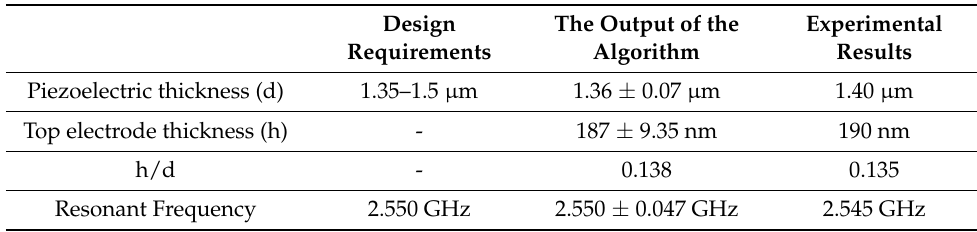
Table 2. Comparison between this work (T.W.) and the state of the art. Table 1. Comparison between design requirements, the output of the algorithm, and experimental